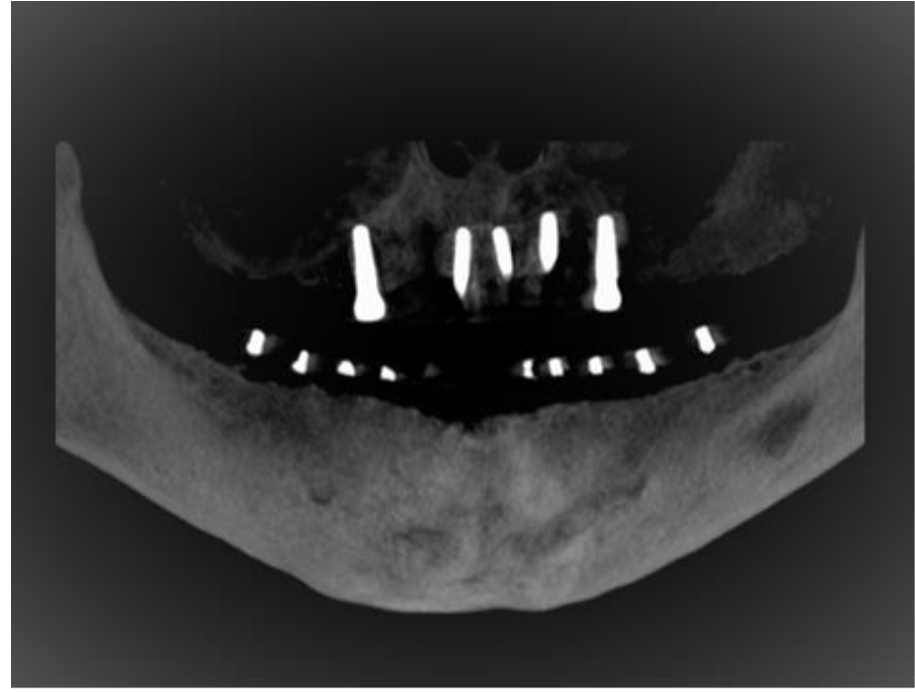
Figure 4. Reformatted panoramic view on CBCT for edentulous mandibular ridge with customized Figure4. ReformattedpanoramicviewonCBCTforedentulousmandibularridgewithcustomizedstent. stent.